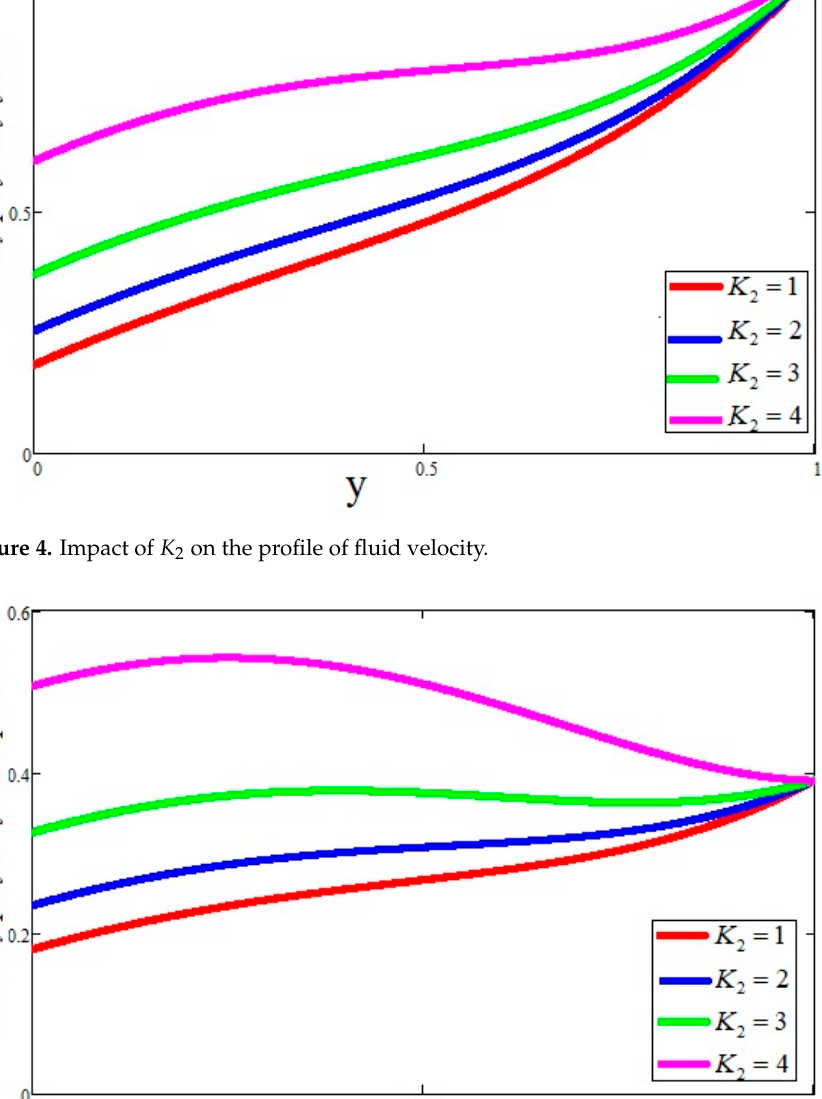
Figure 3. Impact of G r on the profile of dust particles velocity.